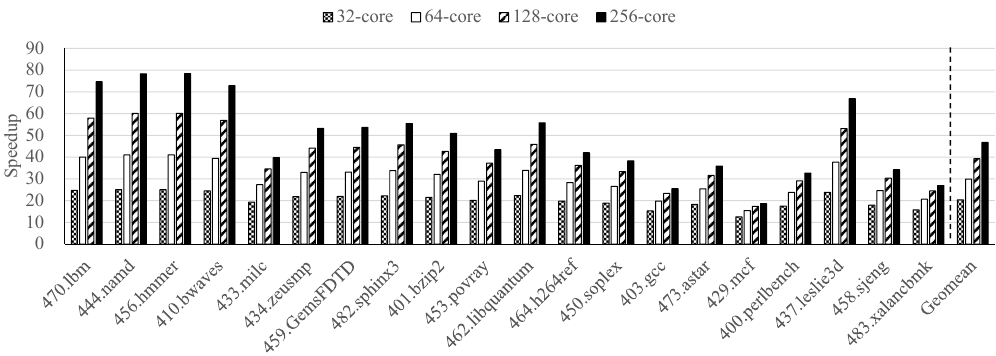
Figure 6. The ideal speedup of EPSim using many cores on the SPEC CPU2006